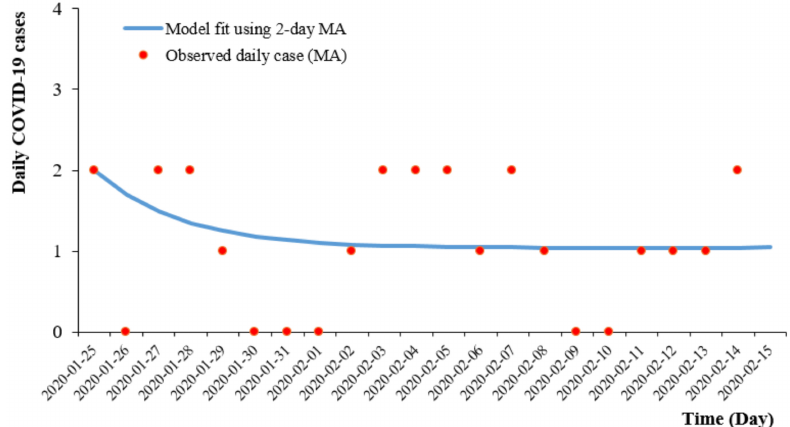
Figure 4. SEIR model fit of first wave COVID-19 cases in